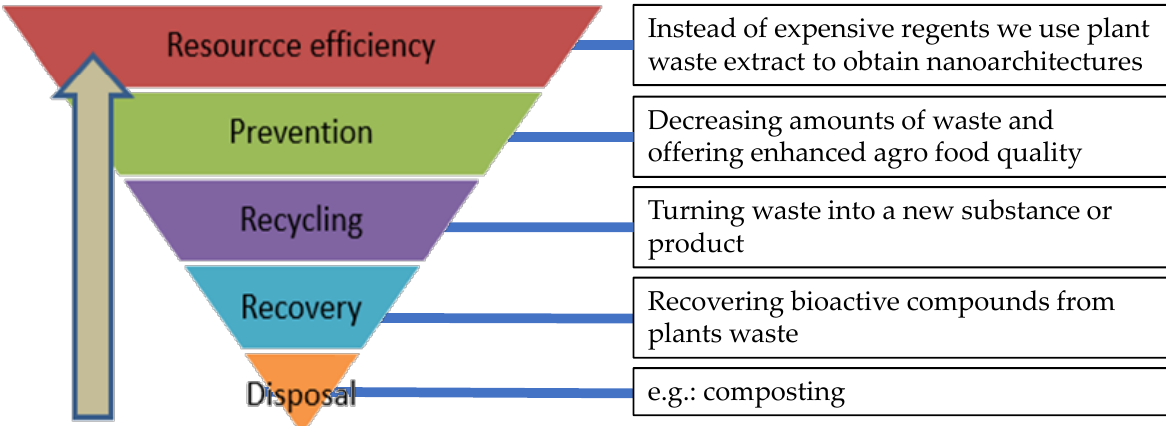
Figure 1. Publication trend (2000–2020) in the field of application of cruciferous vegetables in nanocoating (source of data: https://www.sciencedirect.com, accessed on 28 April 2022). At the international level, only during 2019, the production of cabbage and other re- lated brassicas was 97 million tons with a proportional amount of waste (leaves, roots, some stems, a.o.) [5]. In the last ten years, bioeconomy strategies and policy-related bioeconomy initiatives have been developed all over the world (Figure 2). Europe’s strategy addresses the sustainable production of renewable biomass, value-added products, bioproducts, and bioenergy from different type of wastes through an efficient transformation.